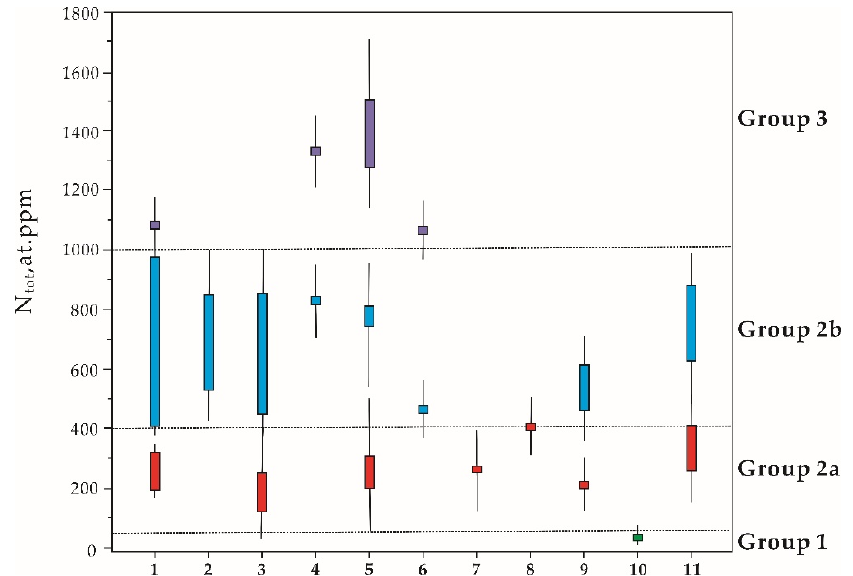
Figure 6. Ranges of variation in the content of structurally bound nitrogen (N tot , at. ppm) in diamond crystals from different areas/placers. Solid columns: concentration ranges of N tot ; short lines: error range. Numbers on abscissa correspond to the area numbers: 1—Placer in the Yangtz Craton,